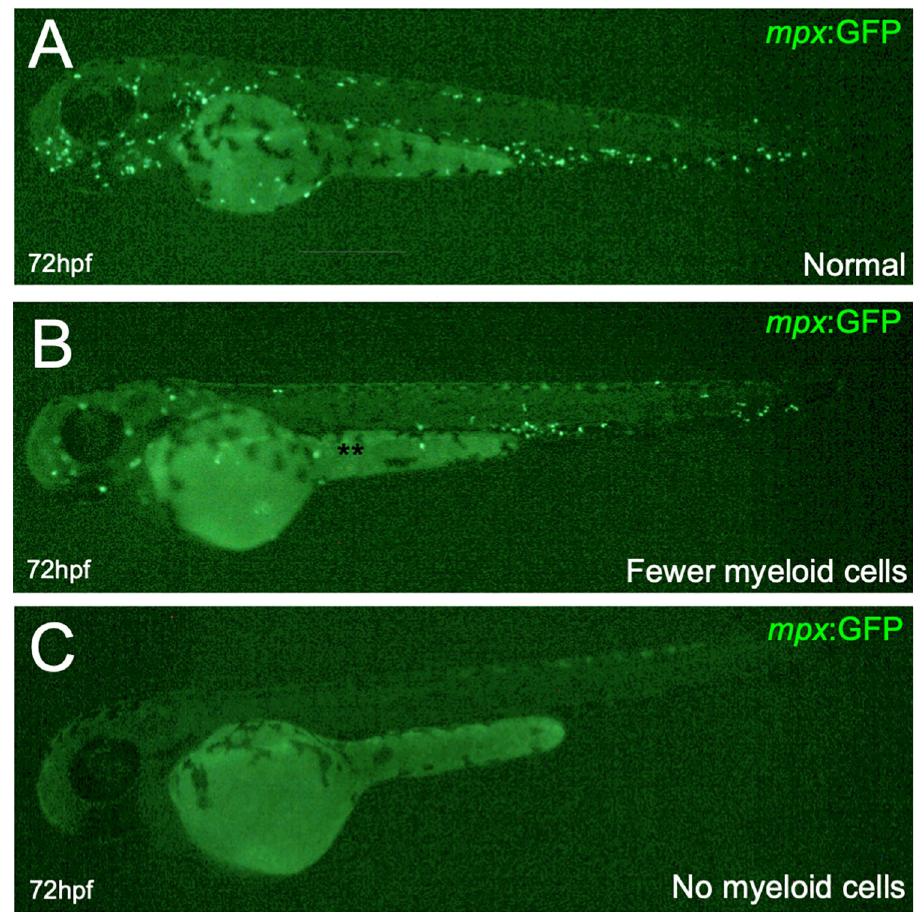
Fig 4. Representative images of myeloid cells after PCP addition. mpx :GFP embryos were treated with 50 μ g/L PCP at 48 hpf and fluorescence was analyzed 24 hours later at 72 hpf. Representative images showing normal (A), reduced (B), and no myeloid cells